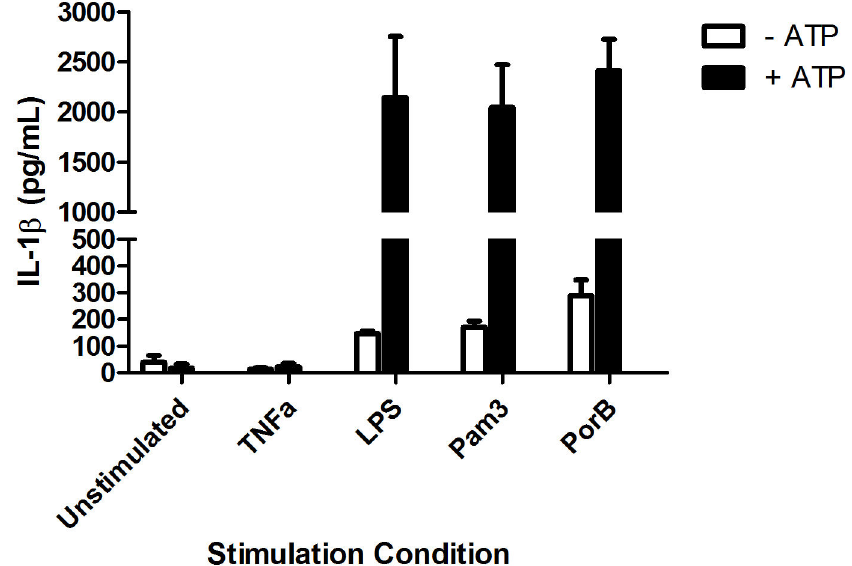
Figure 4. IL-1β induction by PorB requires ATP to activate the inflammasome. WT BMDMs were stimulated with PorB, LPS, TNFα, or Pam CSK at the indicated concentrations for 5 hours. After 5 hours, ATP was added to half the cells for 30 minutes. 3 4 Supernatants were collected and analyzed by IL-1β ELISA. IL-1β release was not observed for PorB, LPS or Pam absence of ATP. In the presence of ATP, significantly increased IL-1β release was observed for all three TLR ligands (p<0.05). doi: 10.1371/journal.pone.0082171.g004 1:50 was determined as quantitation of IgG subtypes could not demonstrated an immune response dominated by IgG1 and be performed in the absence of suitable purified IgG subtype IgG2b (Figure 5b ). These subtypes, in turn, were significantly standards.. WT mice vaccinated with Ova + PorB suppressed in the responses of TLR2 KO mice given the same